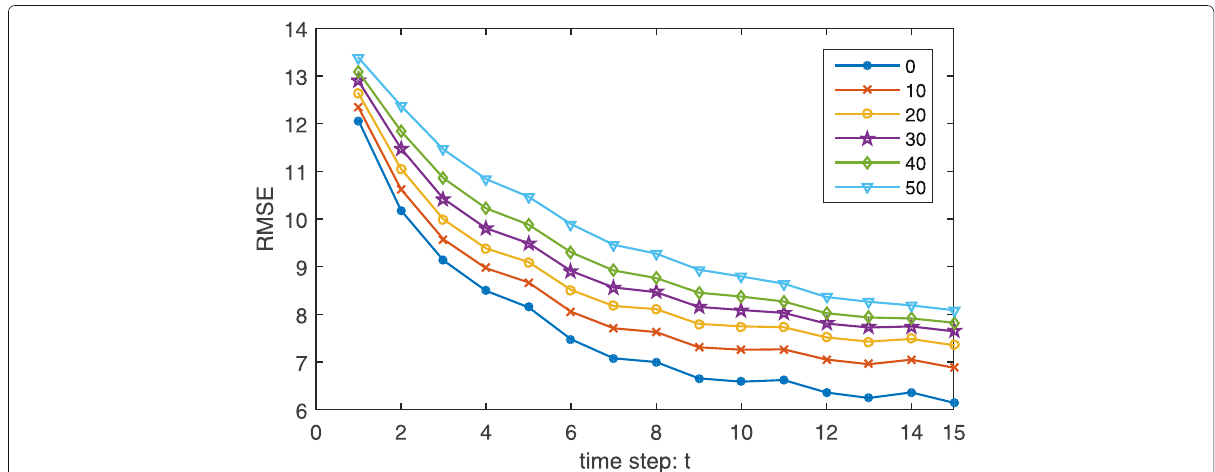
Fig. 2 RMSE of HR images reconstructed by OSR for different noise levels. The data along with the legend are noise variances